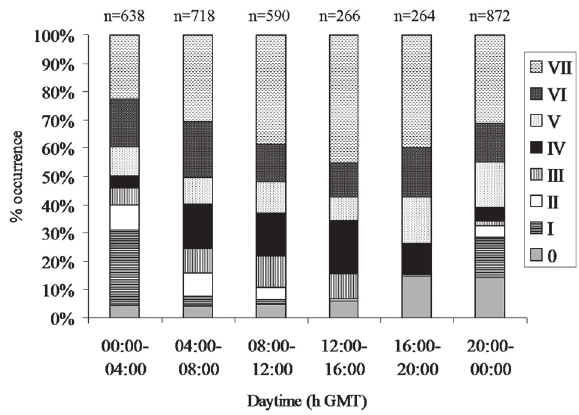
Fig . 3. – PoF incidence-time analysis for the high water tempera- ture dataset (% of occurrence), during four hourly daytime intervals. n represents the number of females examined at each daytime in- terval.